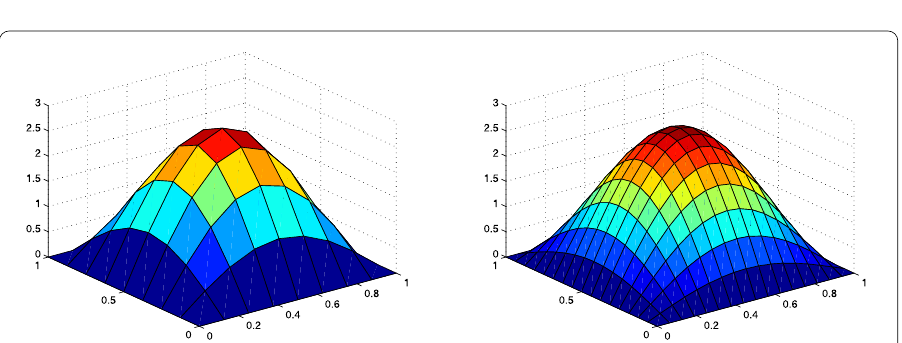
Figure 2 The surfaces of u h at t = 1 s when h = 1